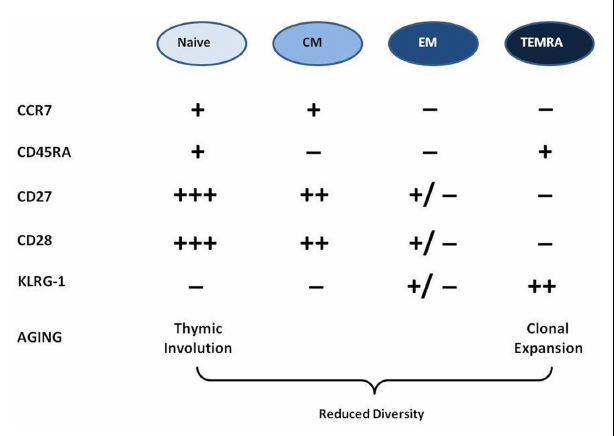
FIGURE 1 | Phenotypic characterization ofT cells and their changes in aging .There are four major differentiation stages ofT cells characterized by the presence or absence of different surface markers in this popular model. With aging the naïve cell compartment is shrinking while the memory is expanding.There is also a loss of diversity with